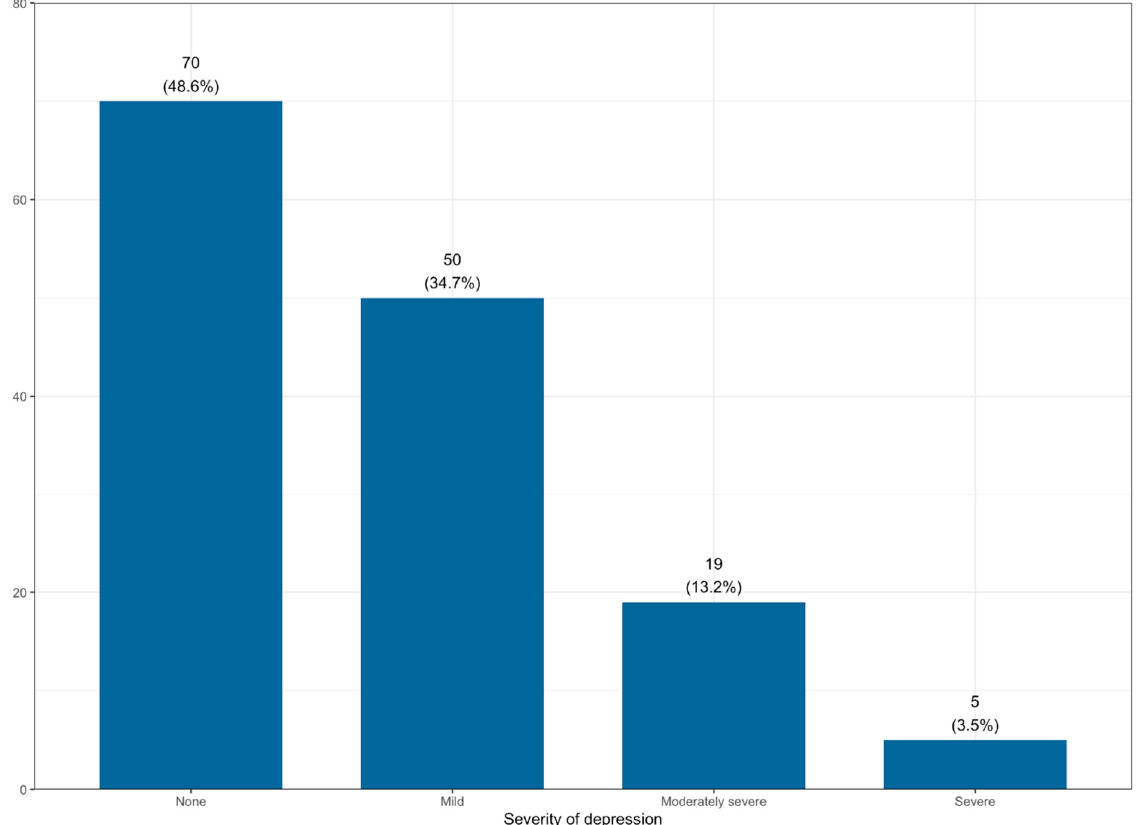
Figure 1. The severity of depression in the sample based on PHQ-9 standards. n = 144.